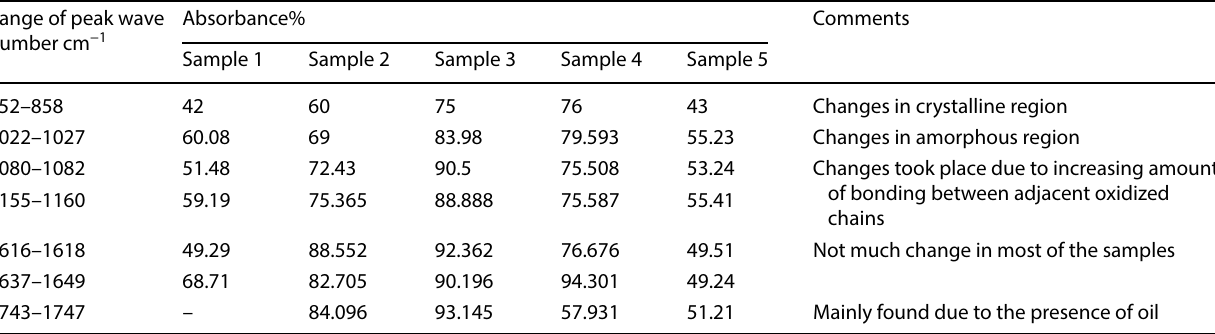
Table 3 Comparative analysis of the percentage of absorbance at the peaks for the tested samples Range of peak wave number cm